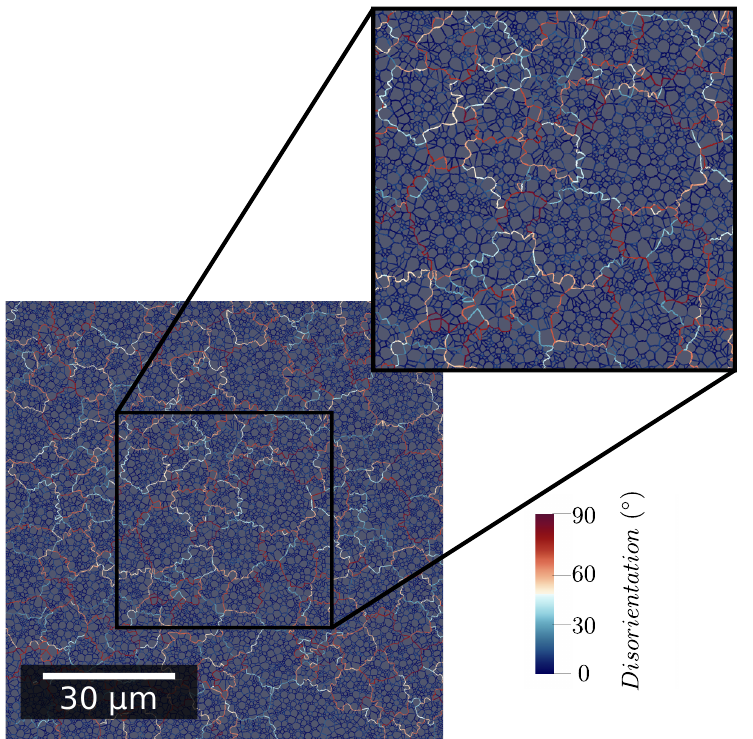
Figure 1. Initial microstructure example with color code corresponding to GB misorientation